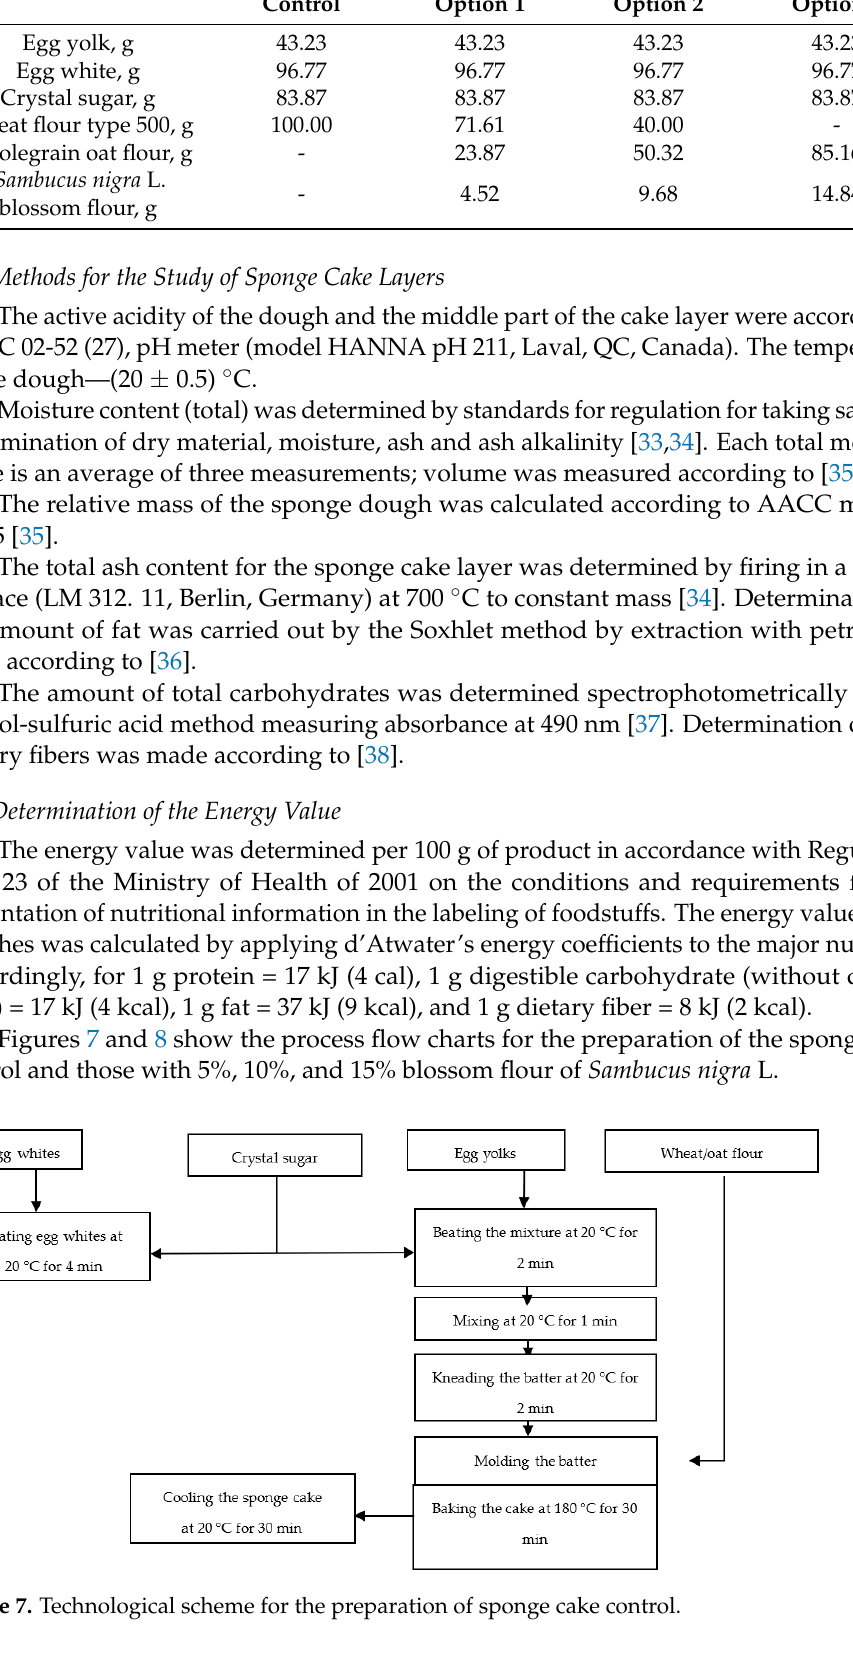
Figure 8. Technological scheme for the preparation of sponge cakes with the addition of Sambucus nigra L. flour (5, 10, and 15%). 4.4. Methods for Microbiological Analysis of Sponge Cake Layers Microbiology is made according to [39–43]. 4.5. Color Characteristics Measurement of the color of the peel and the sponge cake middle parts were made using a quality technical colorimeter PCE-CSM 5, PCE Instruments UK Ltd (Southampton, UK). The indicators are reported by the CIELab system [44]. In the measurement, the color parameters a and b and the luminance L were determined. The color tone and the color tone angle were determined according to dependencies, respectively: C (cid:2911)(cid:2912) = (cid:3493)a (cid:2870) + b (cid:2870) (1) h (cid:2911)(cid:2912) = arctg(b/a)